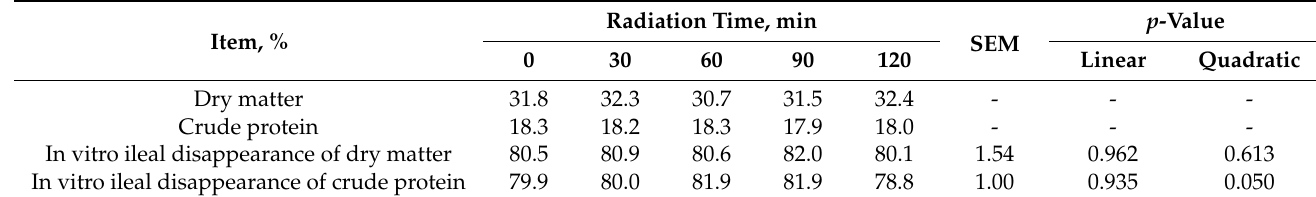
Table 5. Dry matter and crude protein concentrations in ultraviolet-light emitting diode (UV-LED)-radiated chicken meat (as-is basis) and effects of radiation time on in vitro ileal disappearance of dry matter and crude protein of UV-LED radiated chicken meat (Exp. 5) 1,2 .